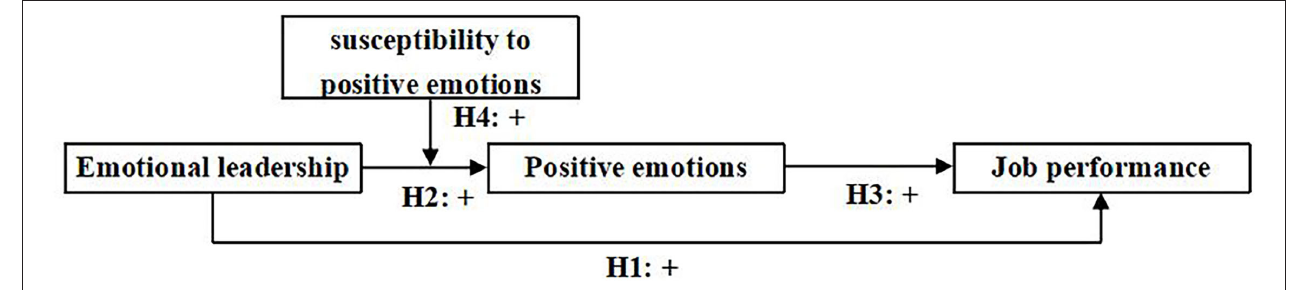
FIGURE 1 | Research